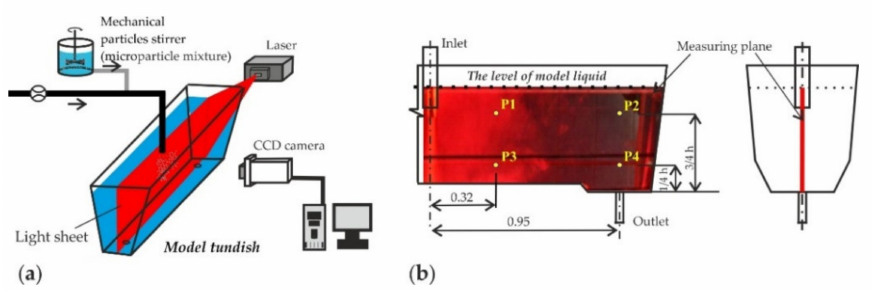
Figure 3. ( a ) Schematic view of the performed experiment, ( b ) Picture showing the location of characteristic points for measurement in the investigated object. Reproduced with permission from ref. [25]. Copyright 2019 WILEY-VCH Verlag GmbH & Co. KGaA,